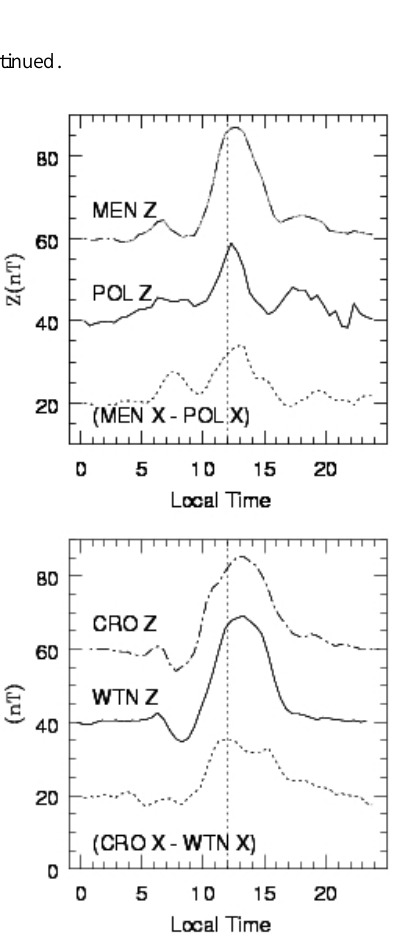
Fig 12. Equivalent current function contours on April 21, 1987, in the European region for various Universal times – from Torta et al (1997)